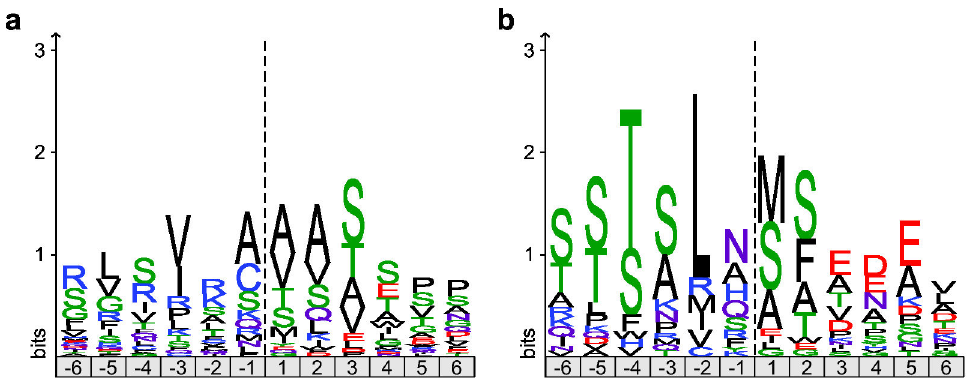
Figure 6. Comparison of transit peptide cleavage sites in higher plants and diatoms. (a) Sequence logo based on 47 acetylated N-termini of chloroplast imported A. thaliana proteins identified by Zybailov et al. as semi-tryptic peptides within 10 amino acids from the predicted cleavage site [29]. (b) Sequence logo based on 30 acetylated N-termini of plastid-targeted T. pseudonana proteins identified in this study. Only acetylated N-termini were used to exclude a potential bias from comparing acetylated sequences from A. thaliana with non-acetylated ones from T. pseudonana . doi: